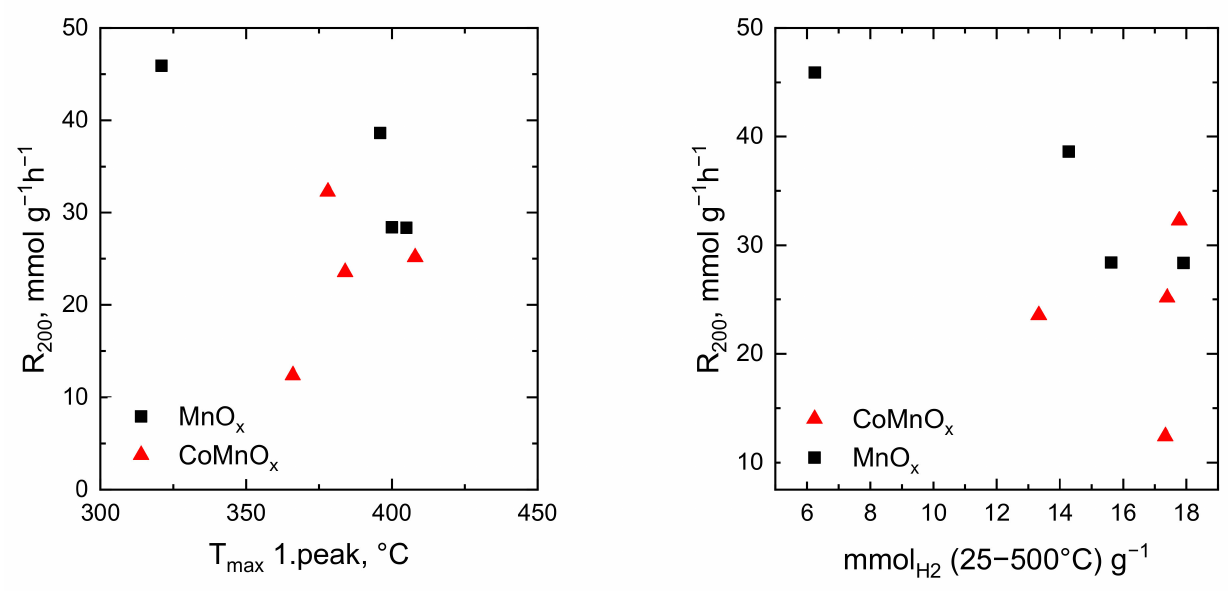
Figure 10. Dependence of R 200 value on the position of the first reduction peak ( left ) and hydrogen consumption per gram of oxides determined in the temperature range 25–500 ◦ C ( right ) in the H 2 –TPR